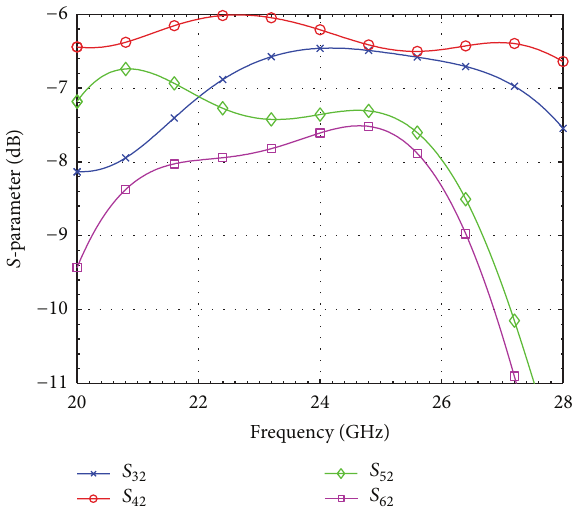
Figure 10: Six-port: simulated transmission from port 2 to the output ports.